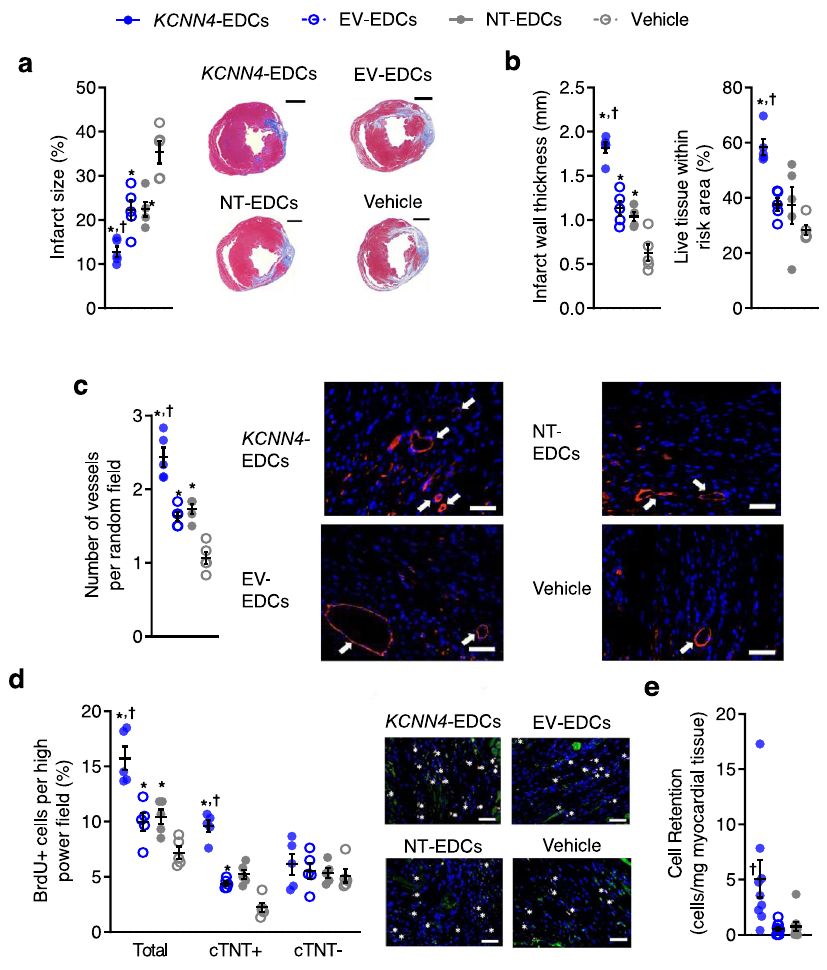
Fig. 6 Effects of KCNN 4 overexpression on infarct properties, neo-angiogenesis, cardiomyogenesis, and long-term engraftment. a Scar size analysis 4 weeks after LCA ligation ( n = 5 biological replicates). Scale bar, 1000 µ m. b Quanti fi cation of infarct wall thickness and viable tissue within the risk area ( n = 5 biological replicates). c Vessel density within the peri-infarct area as indicated (white arrows) using isolectin B4 (red) and 4 ′ ,6-diamidino-2- phenylindole (DAPI; blue) immunohistochemistry ( n = 5 biological replicates). Scale bar, 100 µ m. d The total number of BrdU positive cells (white stars), proliferating cardiomyocytes (BrdU + /cTnT + ), and noncardiomyocyte cells (BrdU + /cTnT − ) quanti fi ed using random fi eld analysis of immunohistochemistry staining with BrdU (red), cTNT (green) and DAPI (blue; n = 5 biological replicates). Scale bar, 100 µ m. e Quantitative PCR analysis for human ALU sequences 21 days after EDC injection ( n = 9 biological replicates). Signi fi cance is indicated in all panels using * P <0.05 vs. vehicle-treated mice, † P <0.05 vs . EV- and NT-EDCs treated mice. For precise P values, see Supplemental Source Data and Statistics fi le. Data are shown as individual points, along with mean and SEM. All data were analyzed using a one-way ANOVA with individual-mean comparisons by Bonferroni multiple two-tailed comparisons test. Blue fi lled symbols = KCNN4 -transduced EDCs, blue open symbols = EV-EDCs, gray fi lled symbols = NT-EDCs, gray open symbols = Vehicle. EDC explant-derived cell, EV empty vector, min minutes, V mem membrane